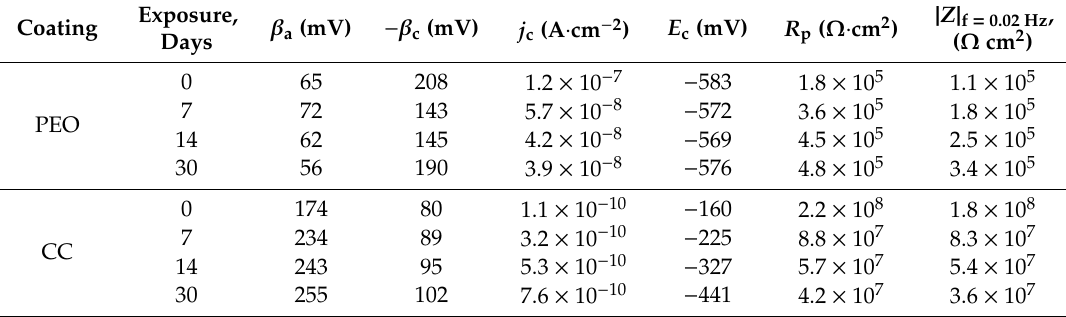
Figure 13. Potentiodynamic polarization curves obtained in 3% NaCl for PEO and composite coatings before and after 7, 14 and 30 days of atmospheric exposure. Table 7. Electrochemical parameters of PEO and composite coatings before and after 7, 14 and 30 days of atmospheric exposure (Figure